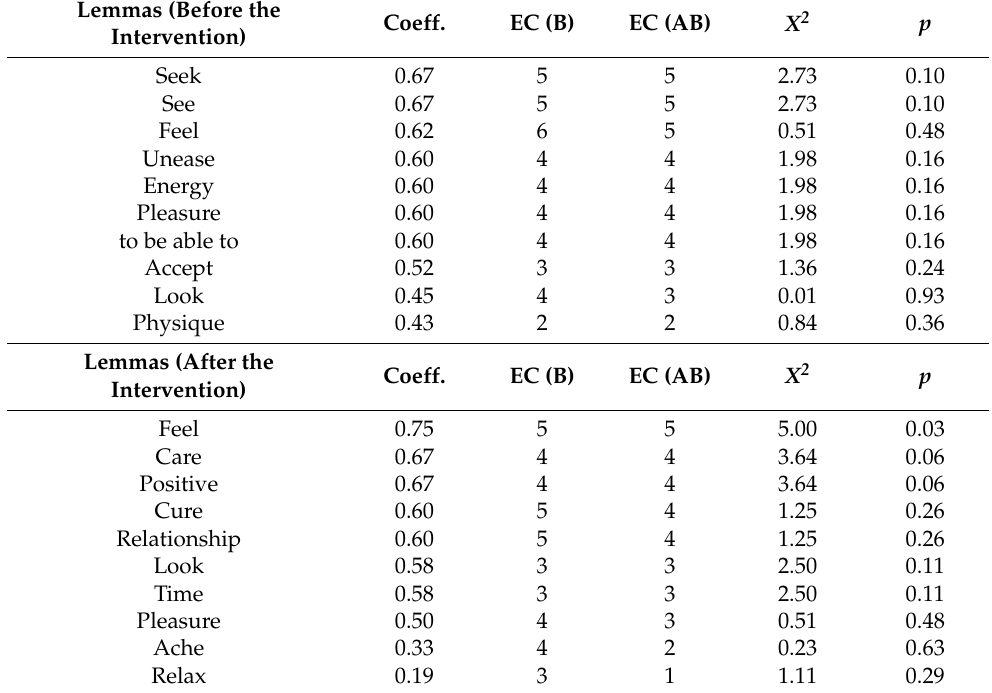
Table 2. Word association analysis before and after the psychological intervention. Lemmas (Before the Coeff. EC (B) EC (AB) X 2 p Intervention) Seek 0.67 5 5 2.73 0.10 See 0.67 5 5 2.73 0.10 Feel 0.62 6 5 0.51 0.48 Unease 0.60 4 4 1.98 0.16 Energy 0.60 4 4 1.98 0.16 Pleasure 0.60 4 1.98 0.16 to be able to 0.60 4 4 1.98 0.16 0.52